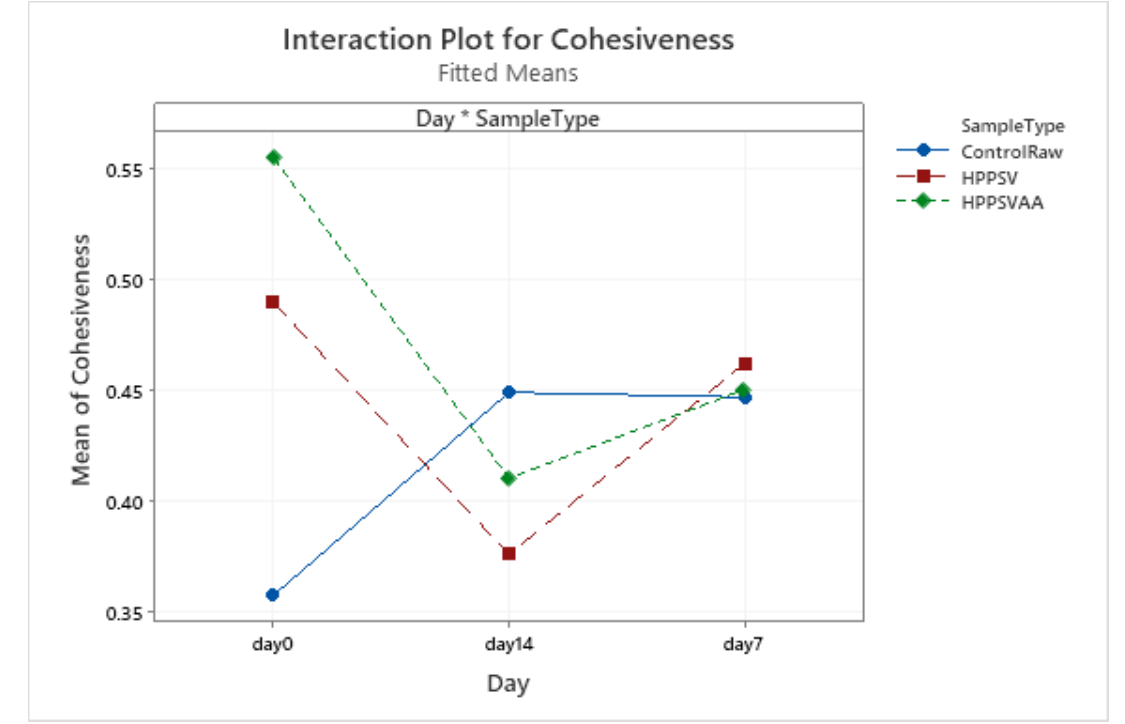
Figure A3. Effect of treatments and storage time on the cohesiveness of veal patty (HPPSV: HPP- SVCOOK).